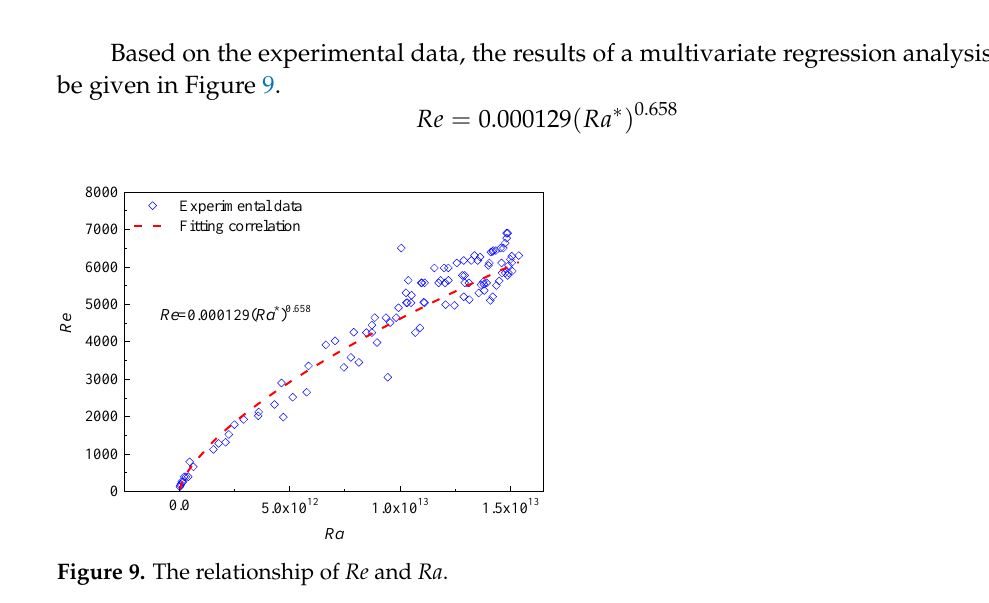
Figure 9. The relationship of Re and Ra .